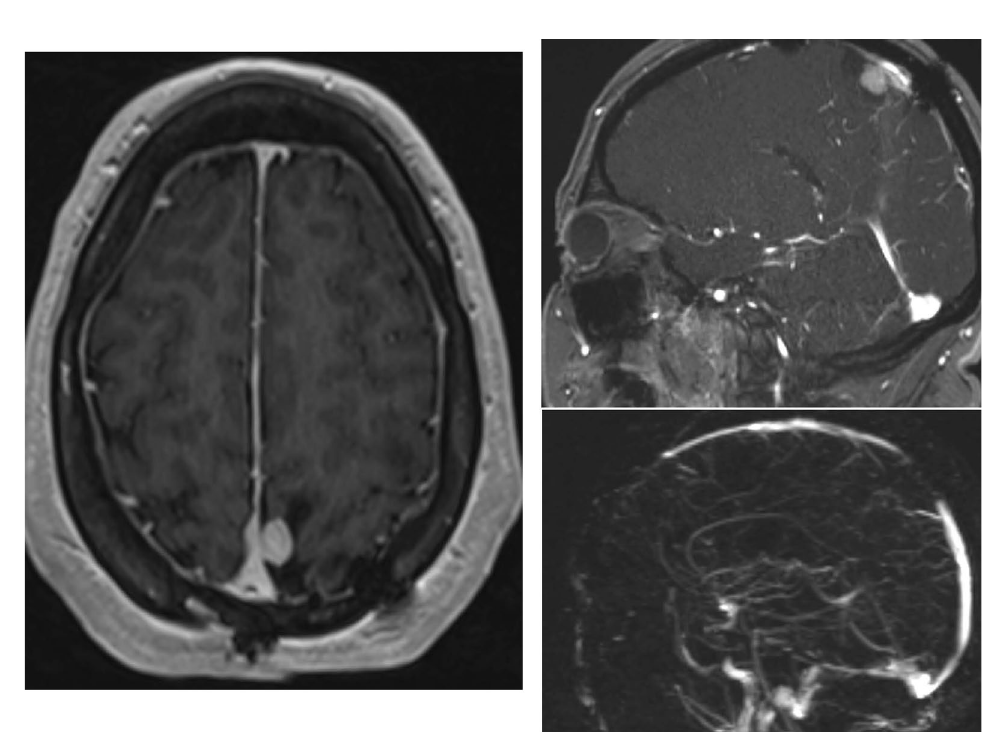
Fig. 3 Representative images of meningioma with encasement and partial occlusion of superior sagittal sinus. Recommended treatment is surgical resection given location